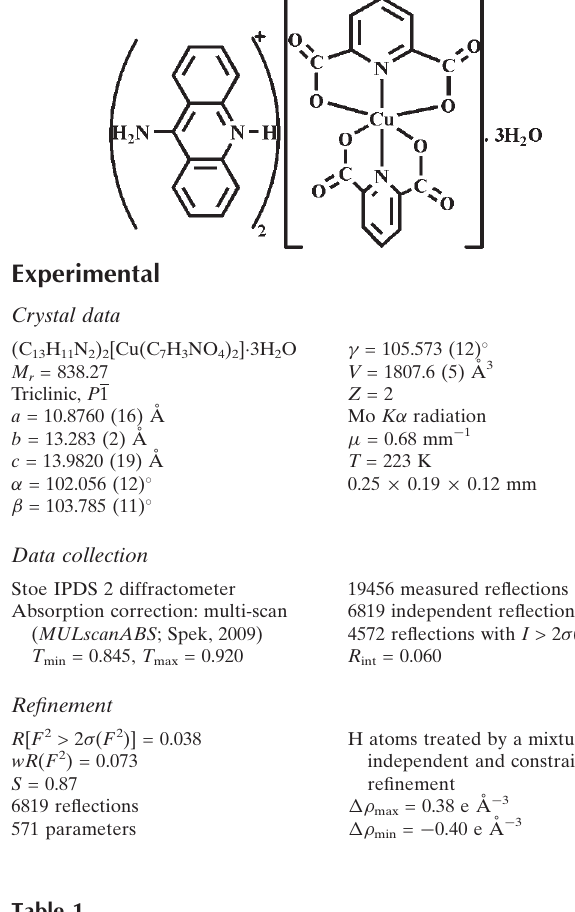
Hydrogen-bond geometry (A˚ , (cid:4) ). D —H (cid:2)(cid:2)(cid:2)